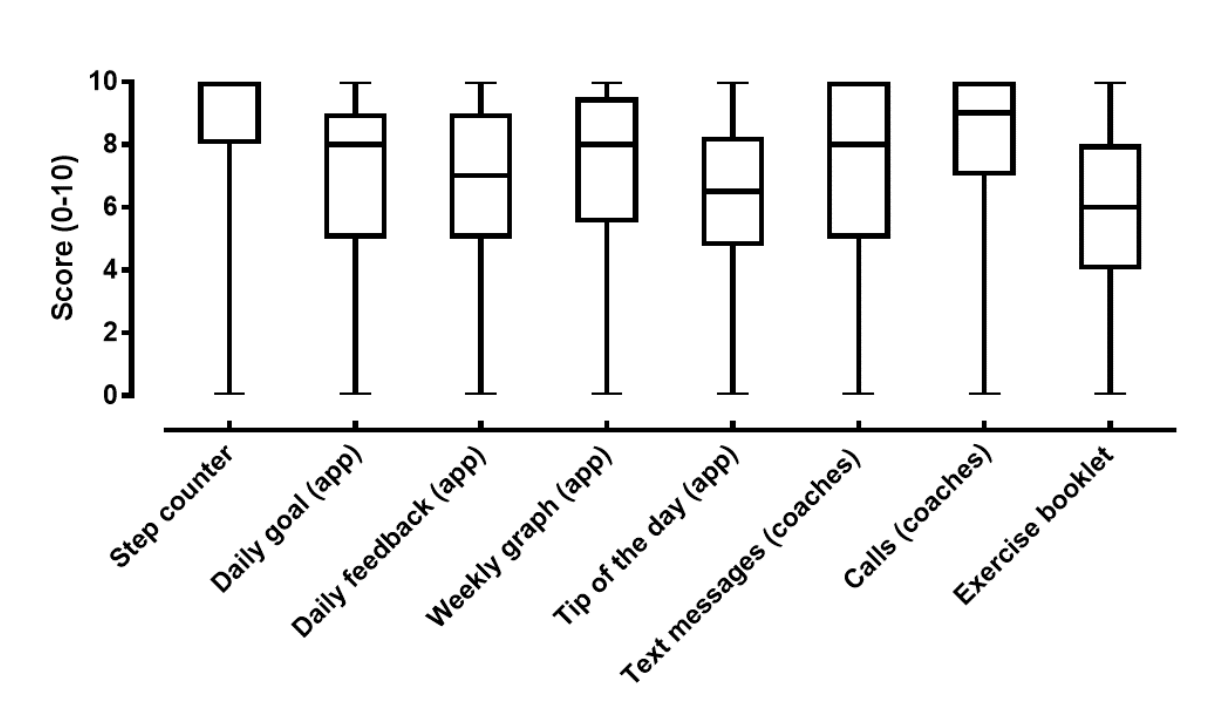
Figure 3. Boxplots depicting the usefulness score (0-10 Likert scale) of the different parts of the intervention from the patients’ perspective. “app” between brackets represents messages displayed on the smartphone